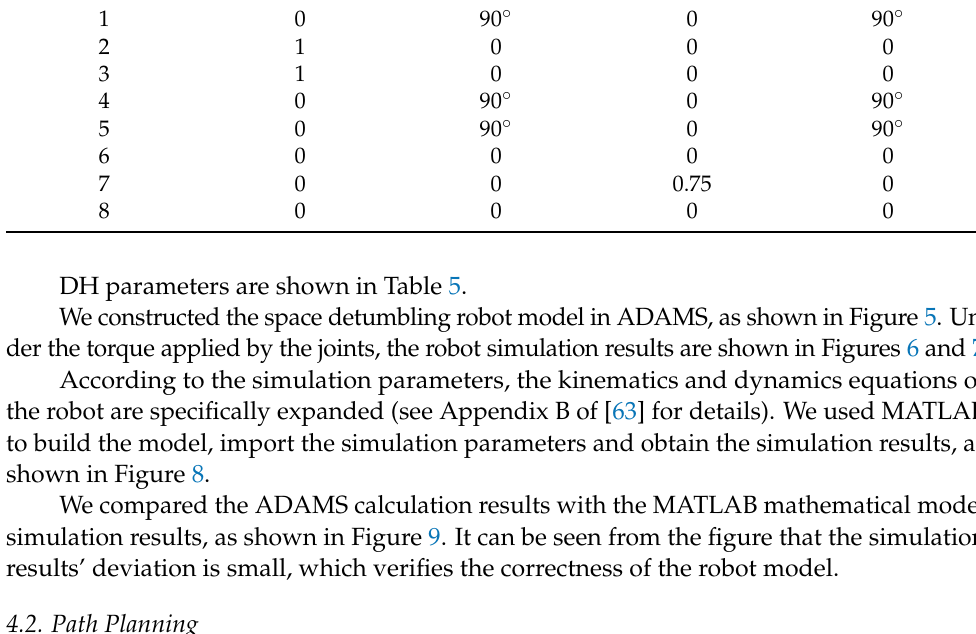
Figure 6. Diagram of the rotation angle of each joint over time (ADAMS).